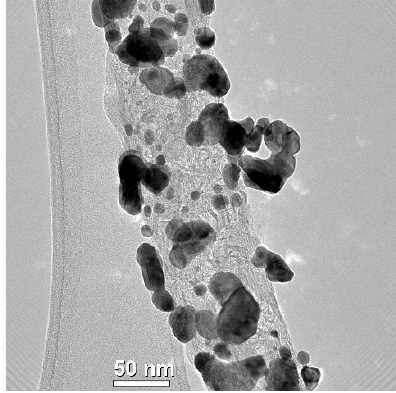
Figure 11. BF TEM images of different parts of nanofibers ( a ) and ( b ) for sample 7 .